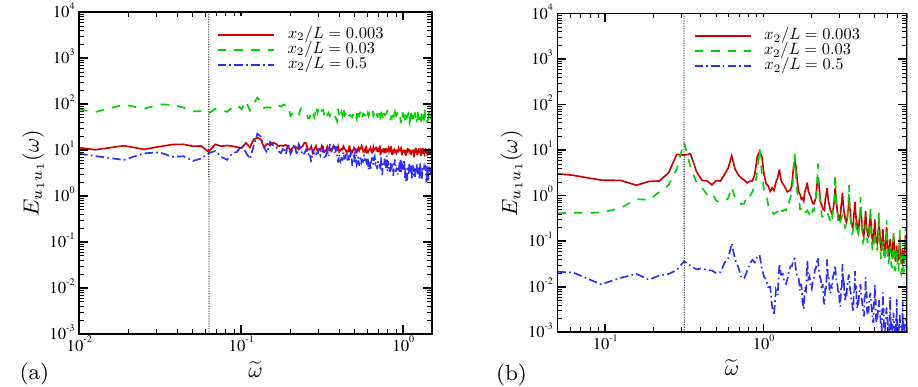
Figure 12. Temporal power spectral density of horizontal velocity at several wall-normal locations. The vertical dotted lines indicate the external AC frequencies ( a )